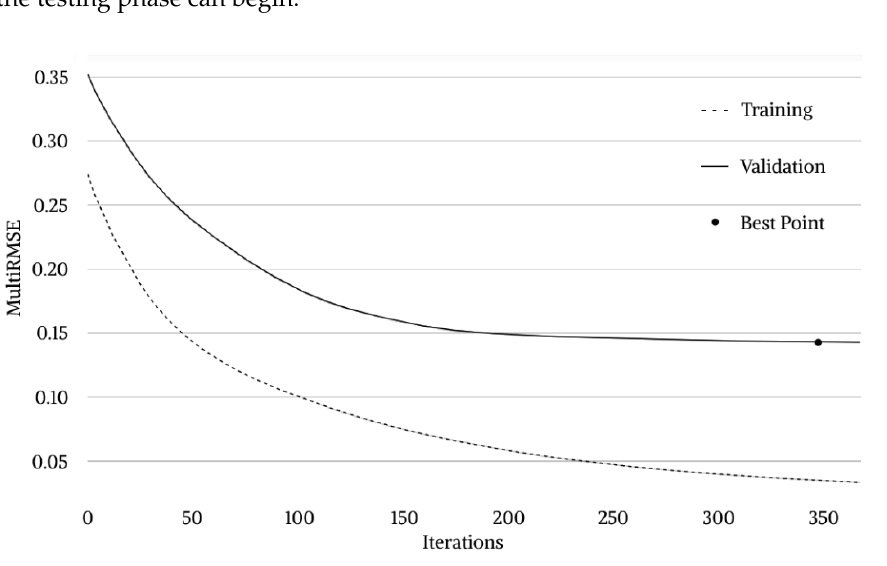
Figure 3. CatBoost model training process.